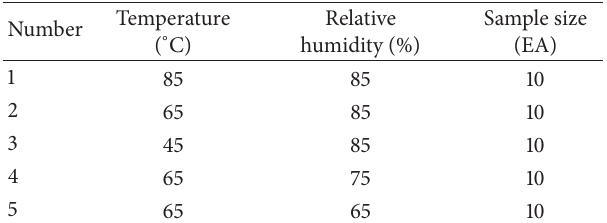
Table 1: Test conditions for accelerated